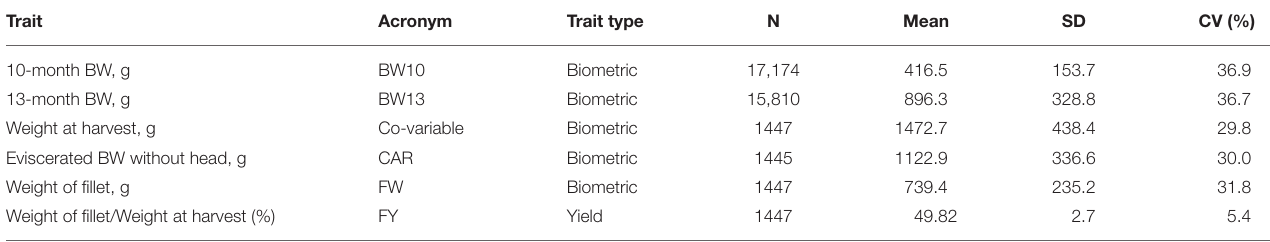
TABLE 1 | Number of observation (n), mean, standard deviation (SD), and coefficient of variation (CV, %) of the analyzed traits and weight at harvest.